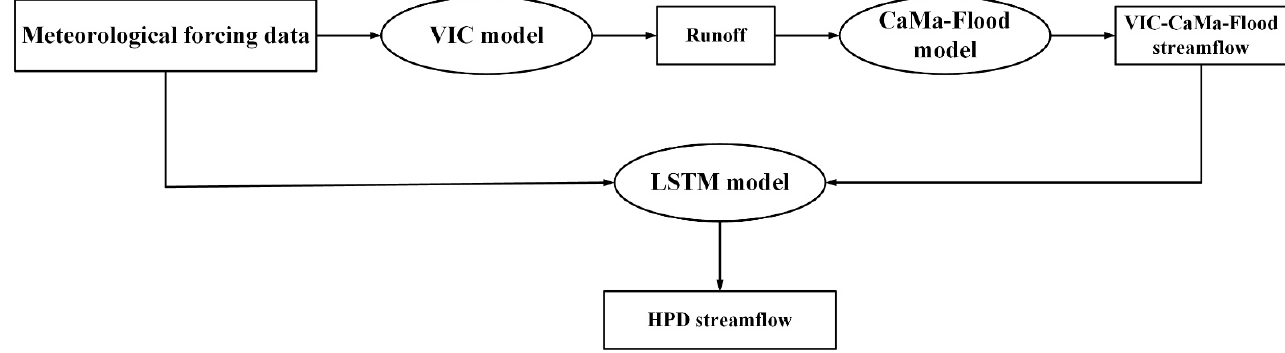
Figure 2. The HPD model based on LSTM model and VIC ‐ CaMa ‐ Flood coupling model.